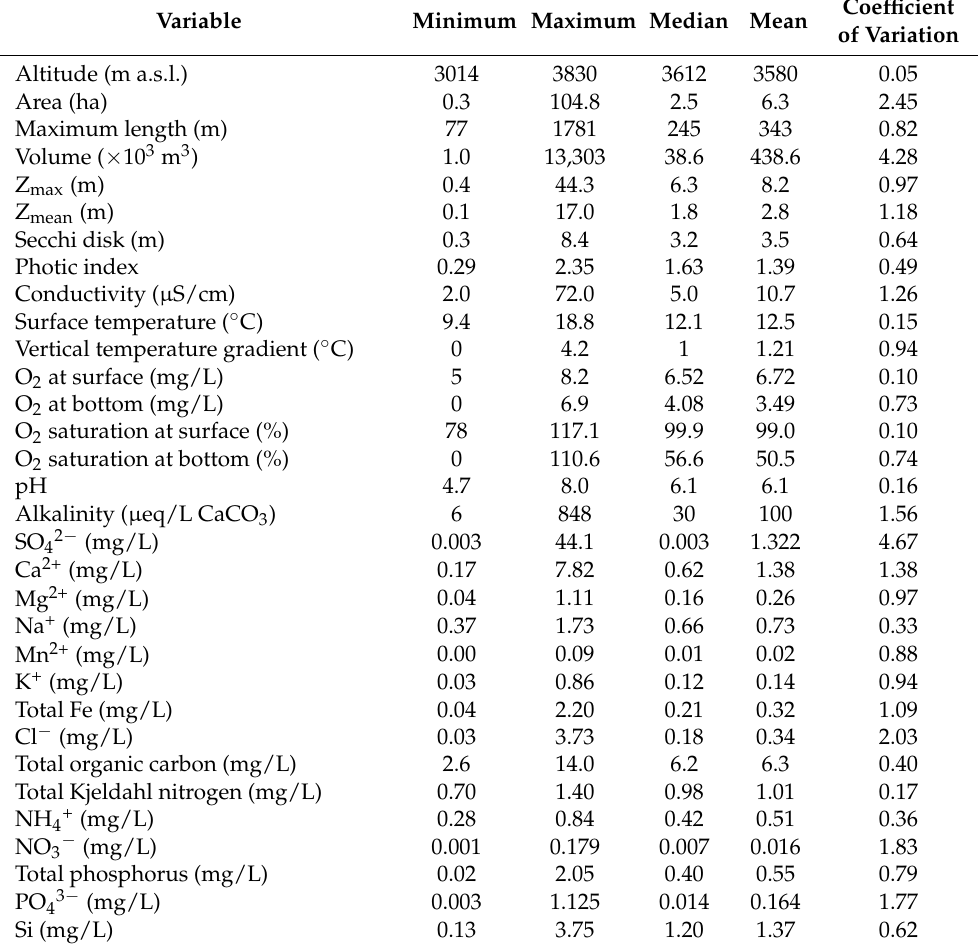
Coefficient of Variation